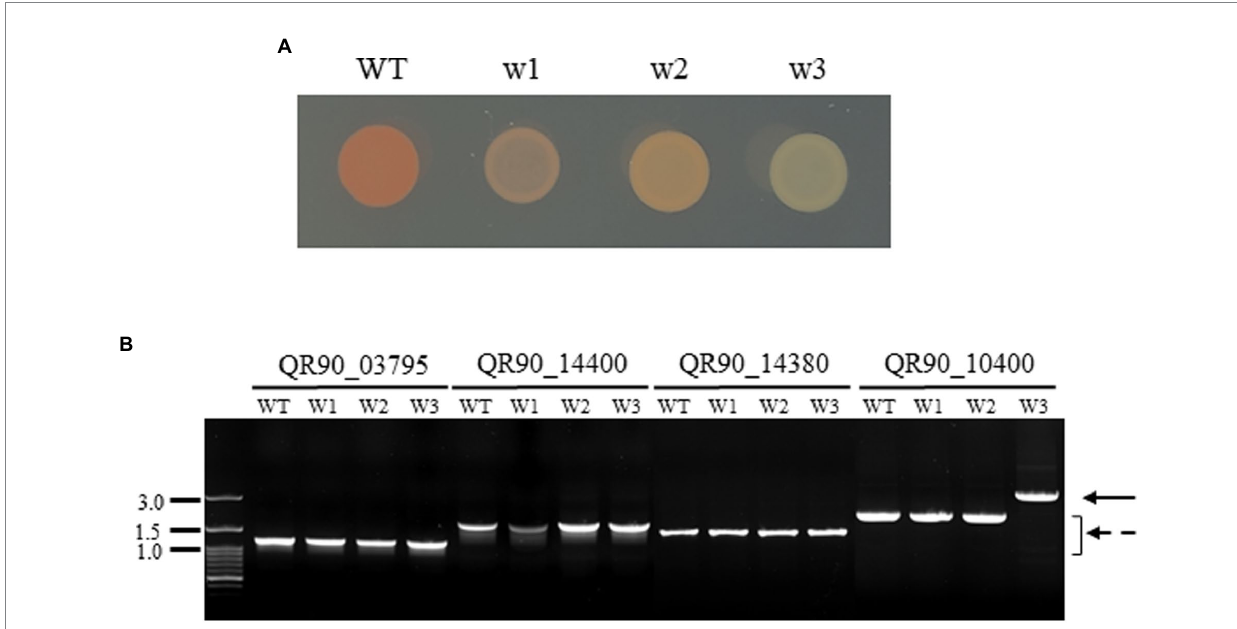
FIGURE 3 Phenotypic diversity in the high concentration of H 2 O 2 treatment (200 mM for w1 and w2 or 300 mM for w3) for 1 h (A) and detection of gene disruption by PCR of genes involved in the carotenoid pathway (B) . QR90_03795, Phytoene synthesis; QR90_14400, FAD-dependent oxidoreductase;